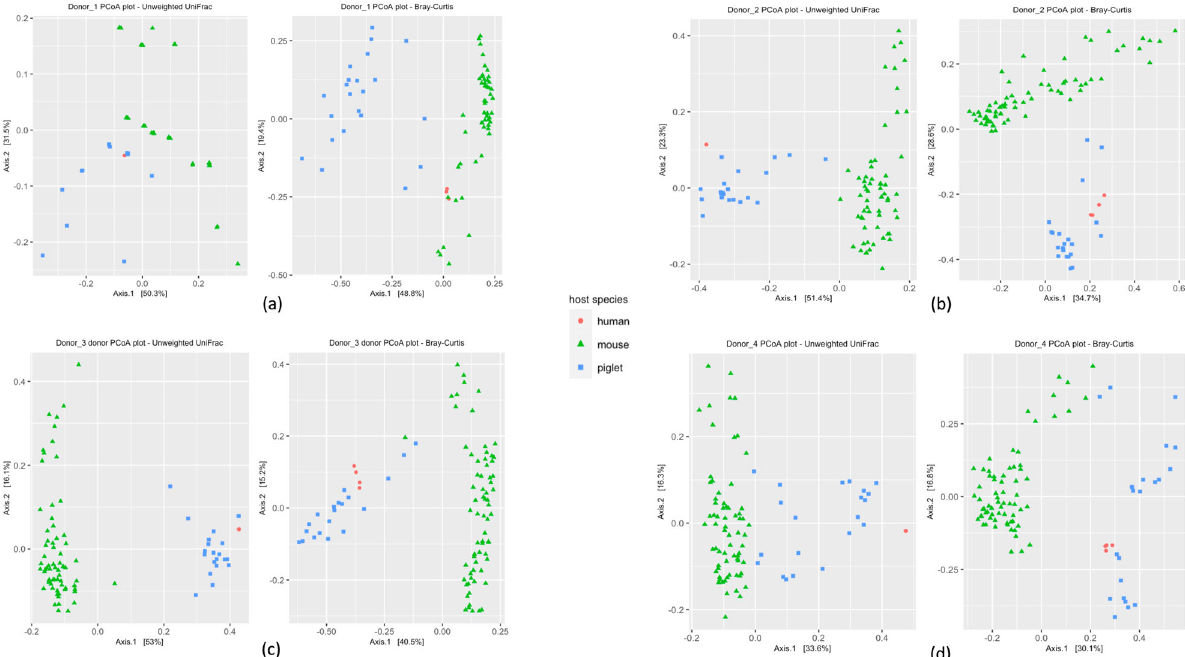
Fig. 2 Principal Coordinate Analysis (PCoA) plots using unweighted UniFrac and Bray-Curtis distances for the bacterial communities in each of the four donor inocula and the fecal samples from the corresponding HMA animal models. ( a ) Donor_1, ( b ) Donor_2, ( c ) Donor_3, ( d ) Donor_4. n = 13 (3 piglets/donor, with the exception n = 4 for Donor_1, 2 days post inoculation) and n = 37 mice (Donor_1 = 7, Donor_2 = 10, Donor_3 = 10, Donor_4 = 10). Red circles, human donor inocula; green triangles, HMA mouse fecal samples; blue squares, HMA piglet fecal